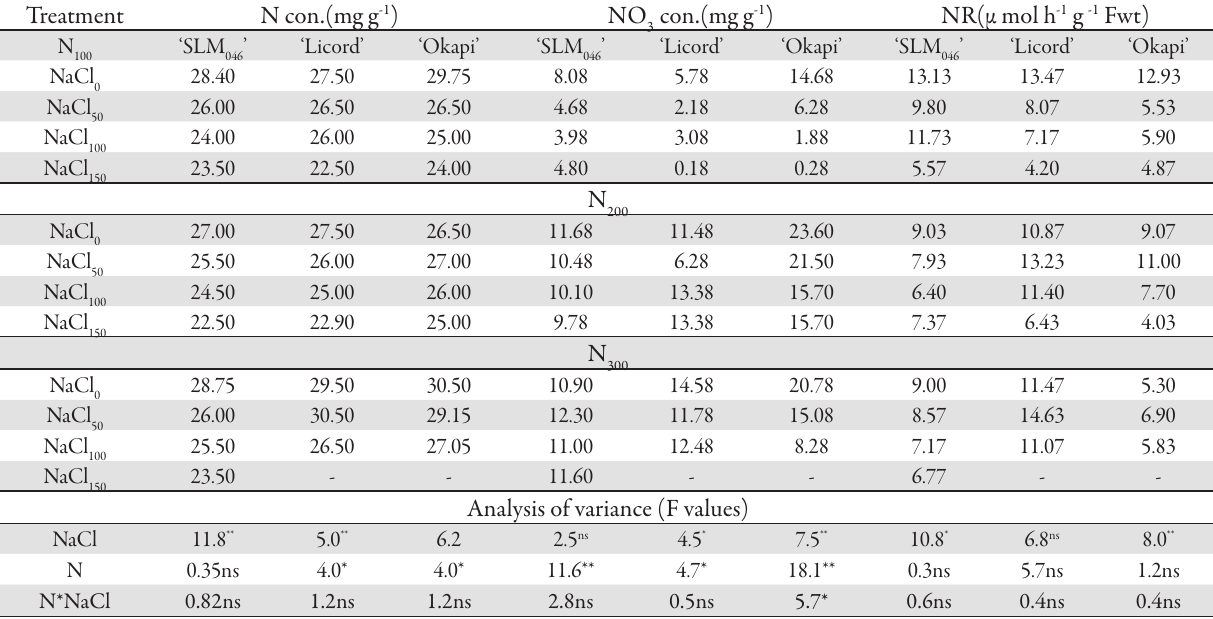
Tab. 4. The effect of salinity and N levels on the vegetative characteristics of canola cultivars